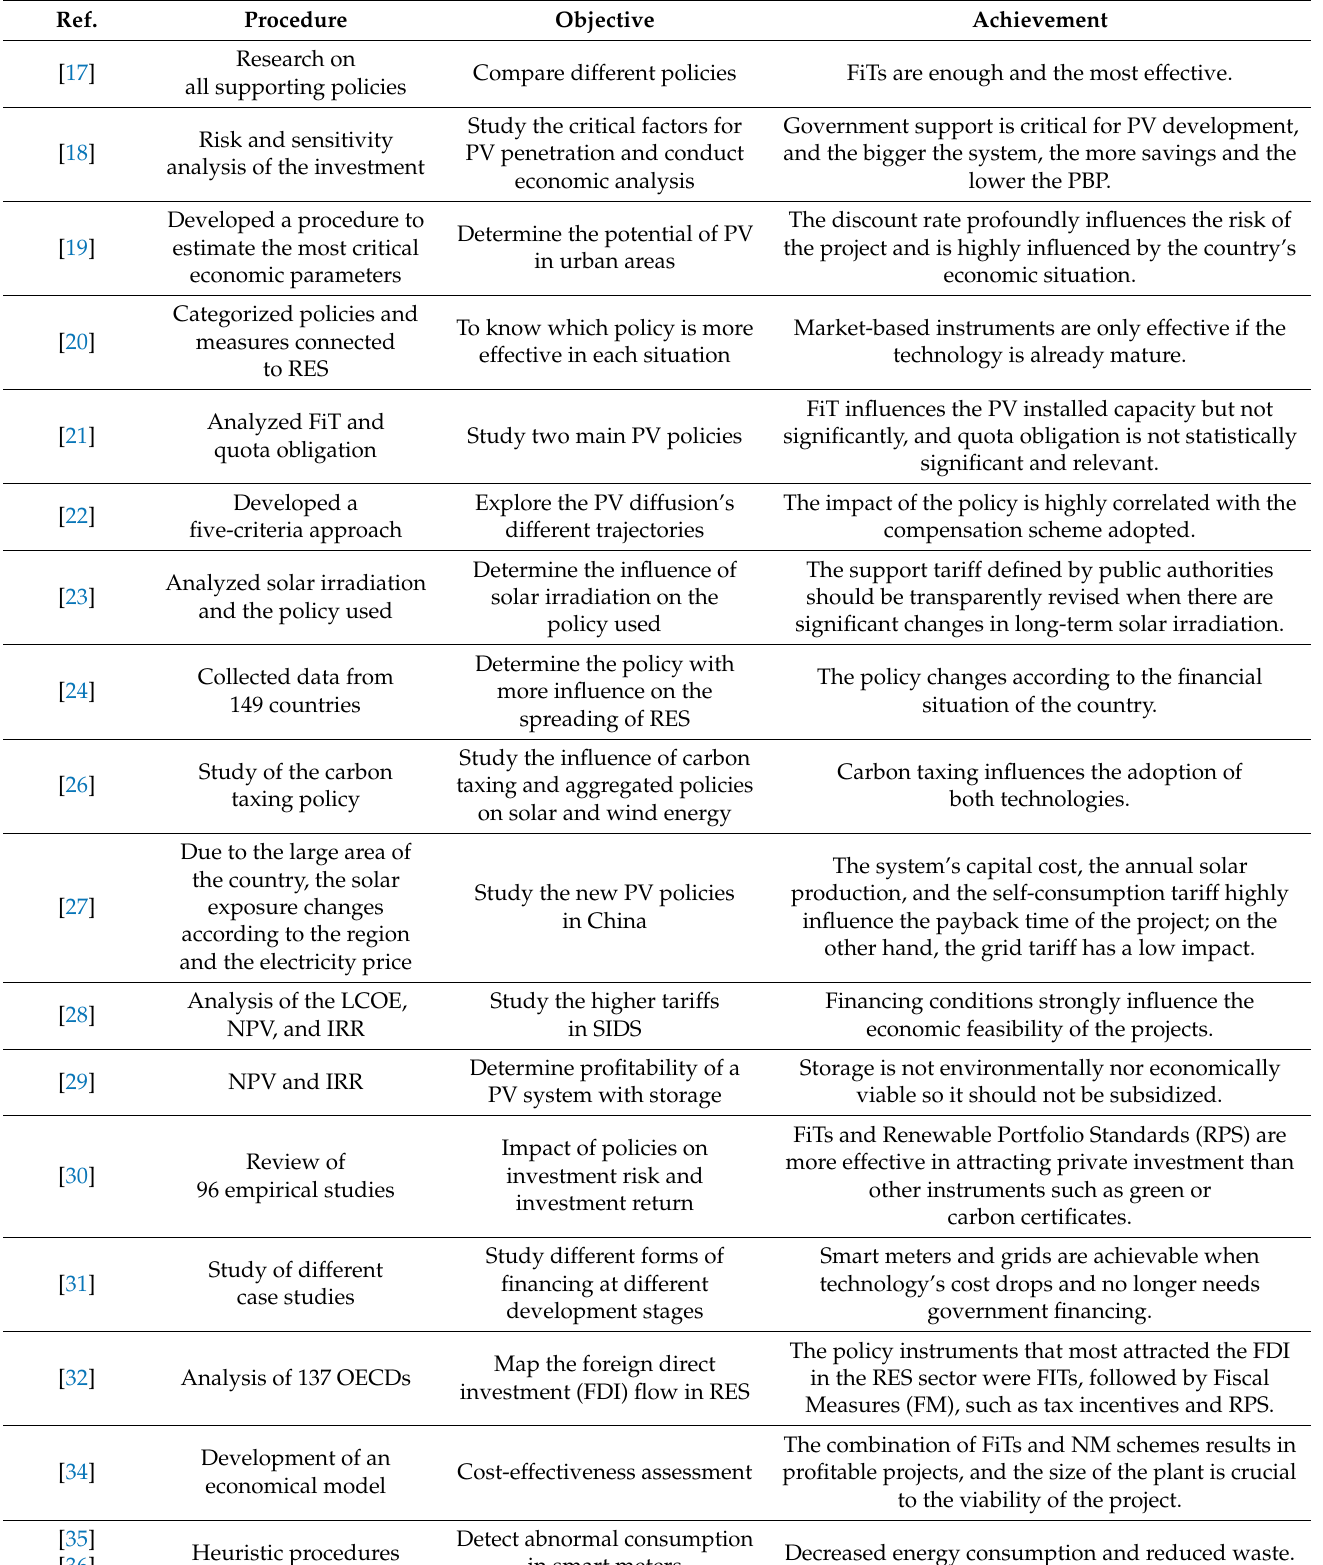
Table 1. Main findings in the